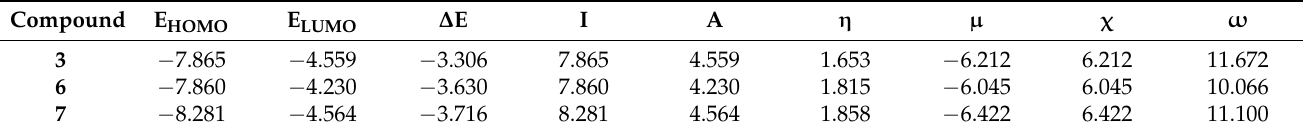
Table 3. The quantum chemical descriptors for compounds 3 and 6–7 .